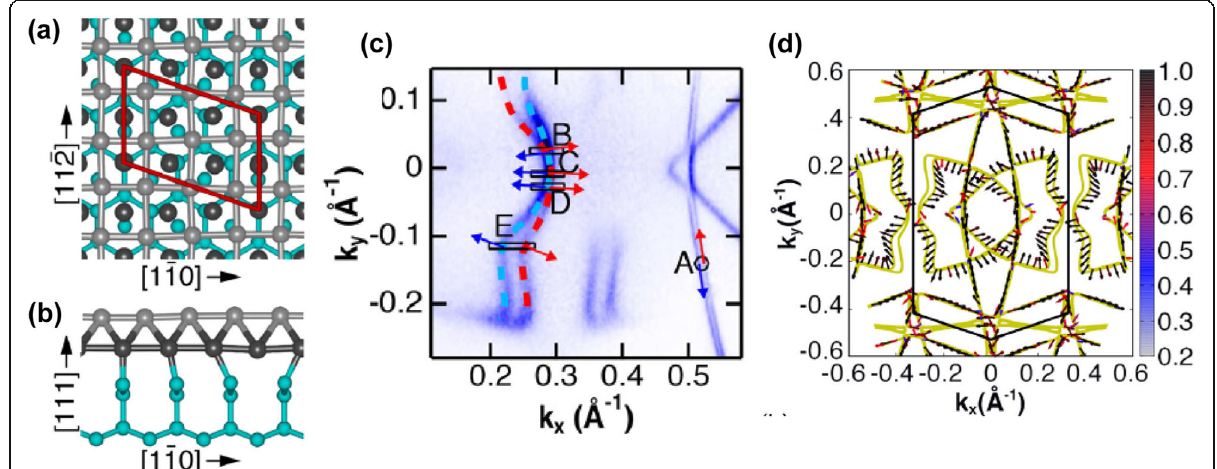
Fig. 5 Crystalline and electronic structures of Si(111)-( √ 7 × √ 3)-In. a , b Atomic structure model. c Fermi surface obtained through ARPES/SARPES measurement. The arrows show the estimated spin directions. d Theoretically obtained Fermi surface and spin polarization (indicated by arrows). Reprinted figure from T. Kobayashi et al. Phys. Rev. Lett. 125 , 176401 (2020) [32]. Copyright 2020 by the American Physical Society.